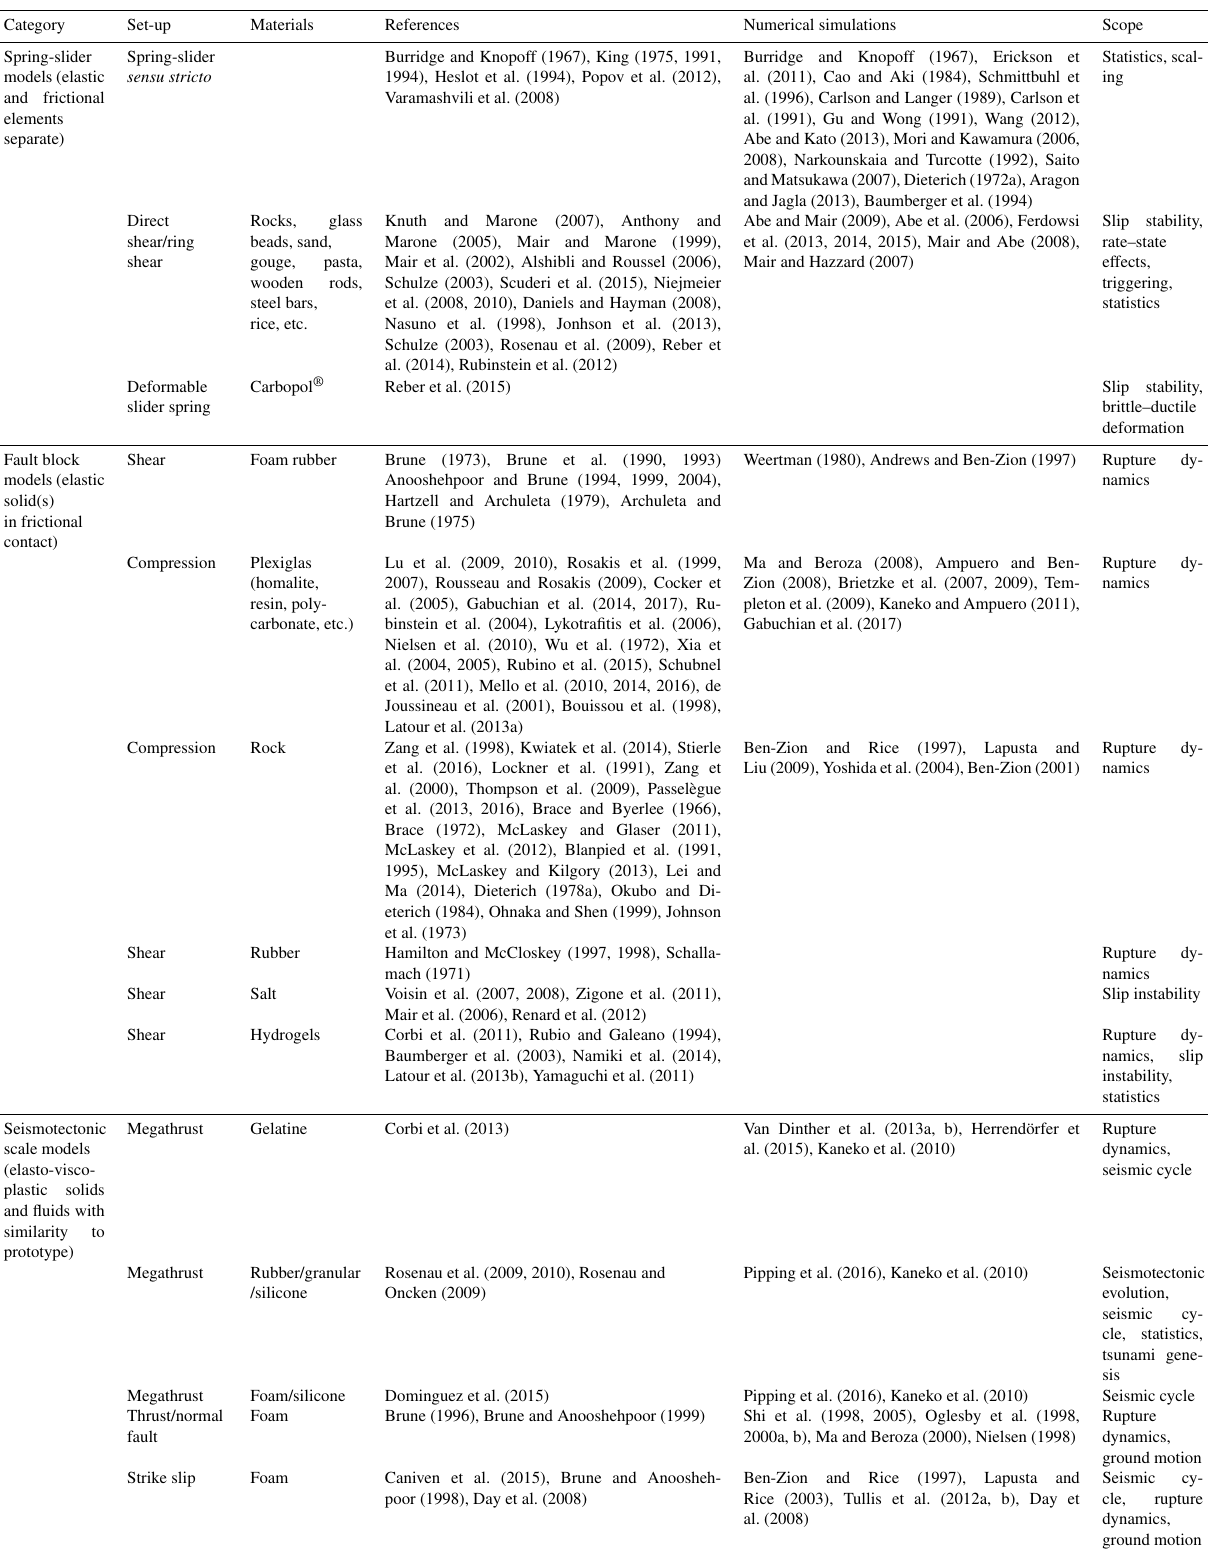
Table 1. Categories of analogue earthquake models (see text for